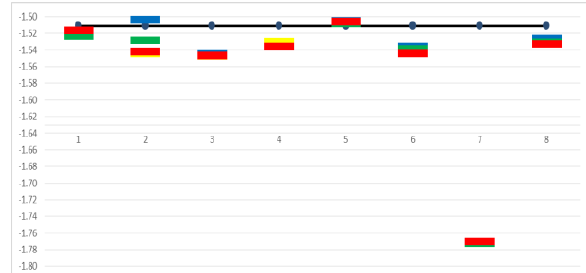
Figure 15. Floor of third level.